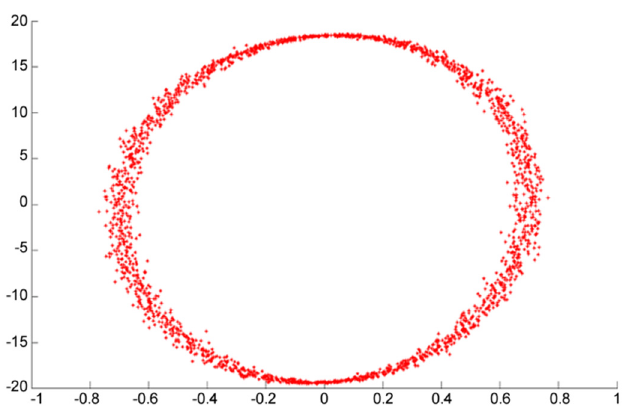
Figure 14. Chaotic trajectory for power system signal with voltage sag disturbance and 5% noise.